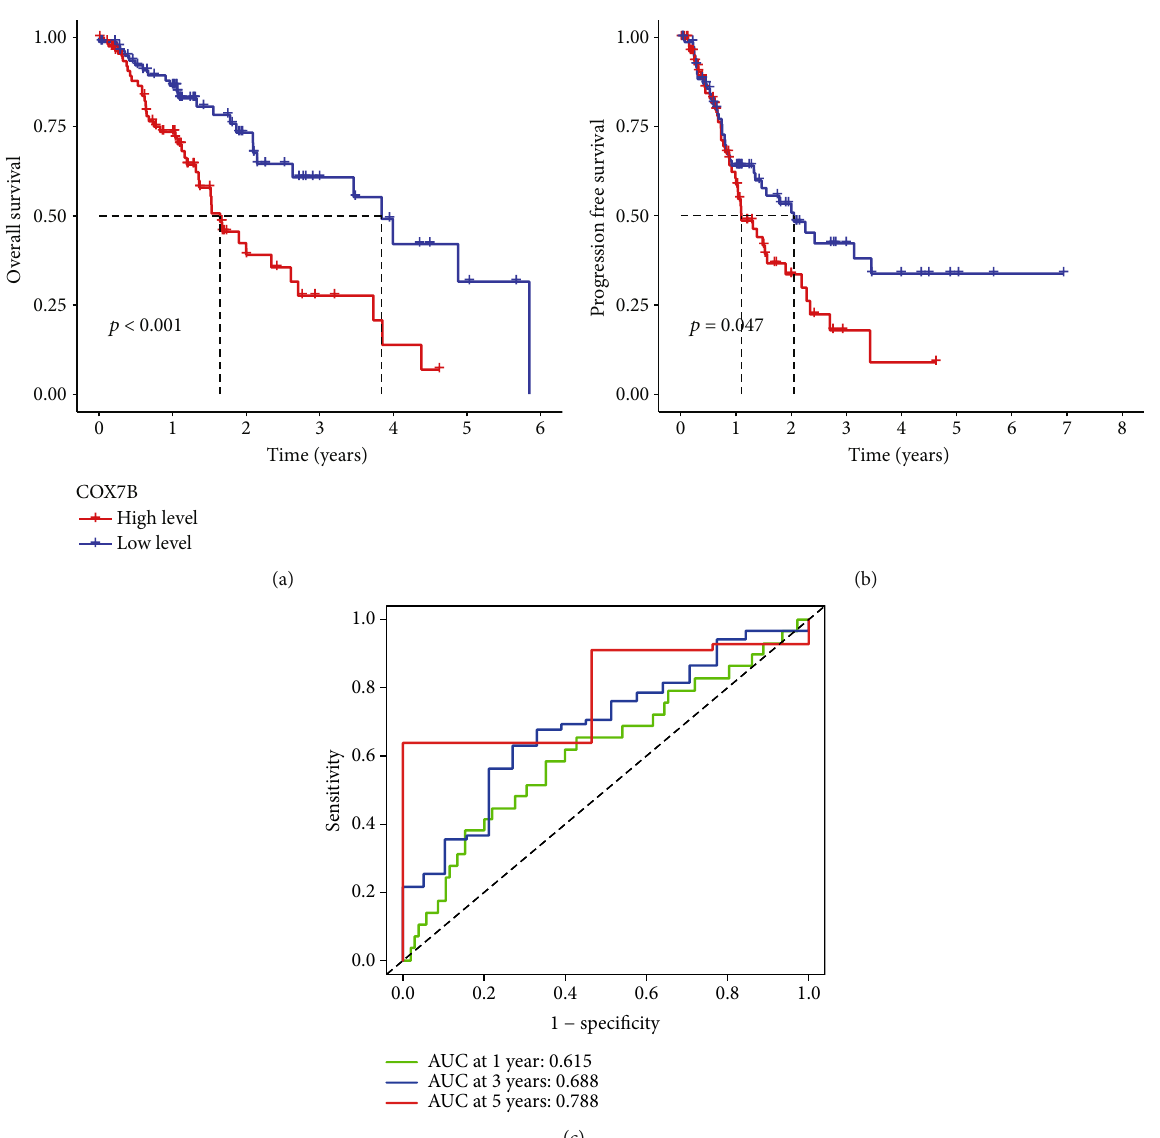
Figure 3: The survival analysis of COX7B in ESCA patients. (a) The OS and (b) survival distributions for PFS were plotted for patients with high and low COX7B expression in ESCA. (c) Estimating the likelihood of survival at 1, 3, and 5 years in ESCA patients using a ROC curve that changes over